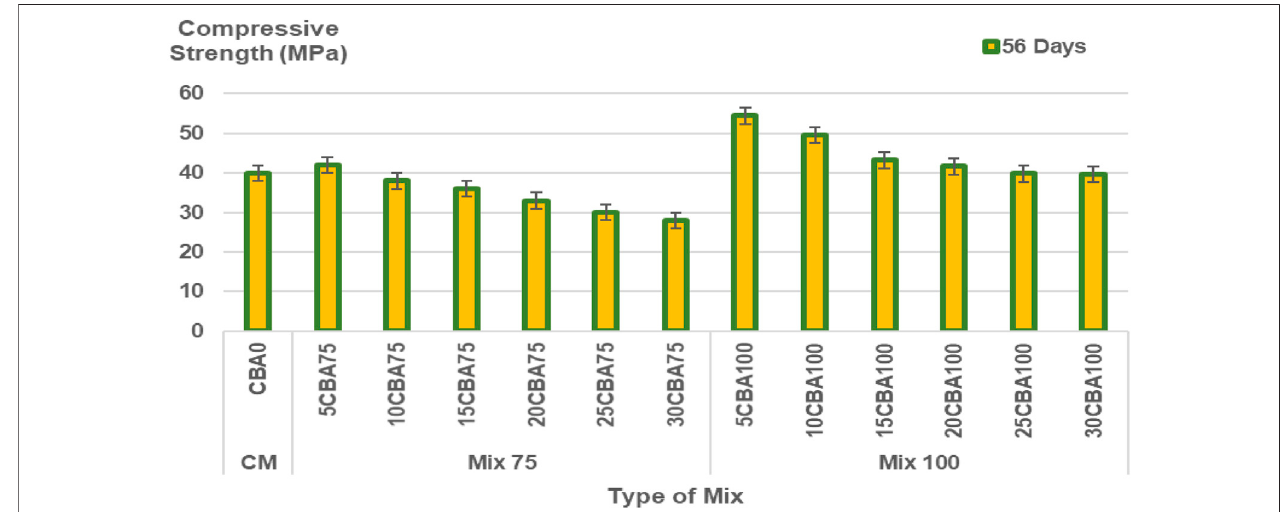
Frontiers in Energy Research |